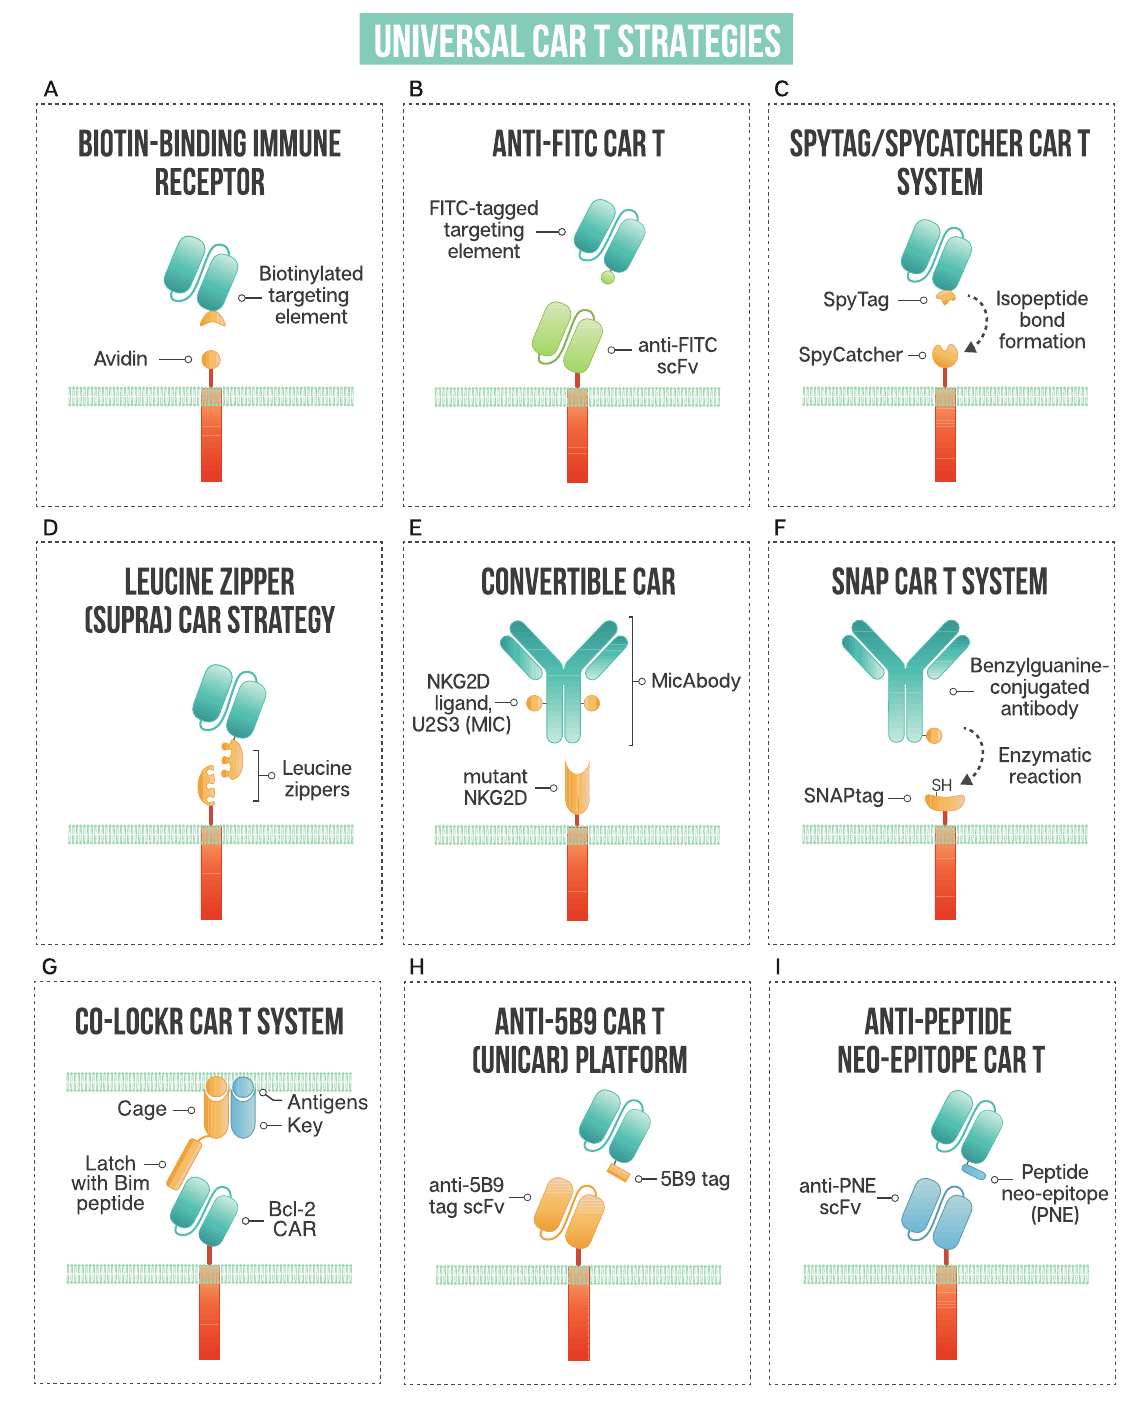
Figure 2. A schematic of strategies used in universal CAR T design: ( A ) biotin-binding immune receptor; ( B ) anti-FITC CAR T; ( C ) the SpyTag/SpyCatcher CAR T system; ( D ) leucine zipper or SUPRA CAR T; ( E ) convertibleCAR or modified NKG2D CAR T; ( F ) SNAP CAR T enzymatic CAR labeling system; ( G ) the co-localization-dependent protein switch (Co-LOCKR) CAR T system; ( H ) UniCAR or anti-5B9 peptide CAR platform; ( I ) anti-peptide neo-epitope (PNE) CAR T. Lohmueller et al. [14] drew on this system and further affinity enhanced streptavidin, designing a biotin-binding domain where monomeric streptavidin could be used in the CAR system with higher affinity to biotin than the dimeric form. This affinity-enhanced form, mSA2, has a more compact structure than the dimeric form employed previously, possibly increasing the type of antigens able